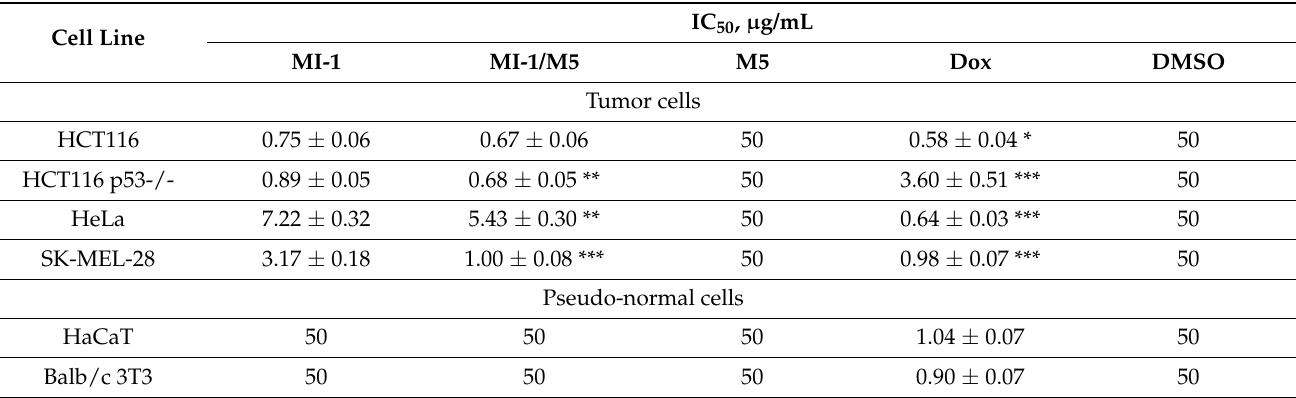
Figure 3. The cytotoxicity of MI-1 maleimide derivative, its complex MI-1/M5 with polymeric carrier, free polymeric carrier poly (PEGMA- co -DMM) (M5), doxorubicin (Dox), and solvent DMSO towards human colon carcinoma HCT116 and HCT116 p53-/- cells, human cervical adenocarcinoma HeLa cells, and human melanoma SK-MEL-28 cells. The effect was measured by the MTT assay under 72 h cell exposure. Data are presented as the mean ± SD. * p < 0.05; ** p < 0.01; *** p < 0.001 compared with control (non-treated) cells. Table 1. The cytotoxicity (GI 50 ) value of studied compounds towards the mammalian cells (MTT assay, 72 h of